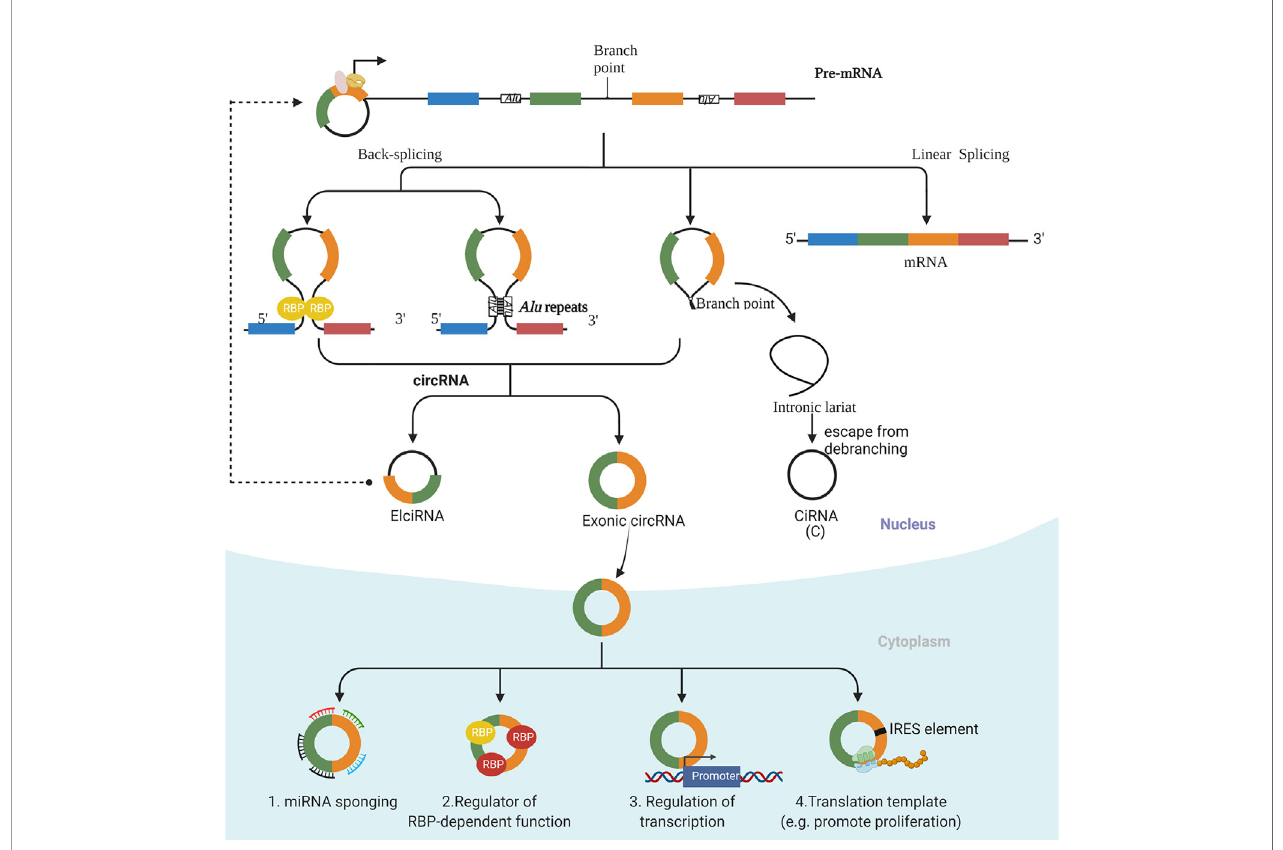
FIGURE 1 | The biogenesis and function of circRNAs. There are three main types of circRNAs, including exonic circRNAs, which consist of only exon(s), exon-intron circRNAs (ElciRNA), which consist of both exon(s) and intron(s), and intronic circRNAs (CiRNA), which consist of only intron(s). An exon-intron circRNA can regulate the expression of its parental gene through binding to its promoter. The mechanism of regulation by exonic circRNAs include serving as a decoy for binding to microRNAs (miRNAs); interacting with speci fi c binding elements on RBPs and acting as a sponge to regulate the functions of RBPs and to affect the activities of associated proteins; regulating transcription; and acting as templates to encode